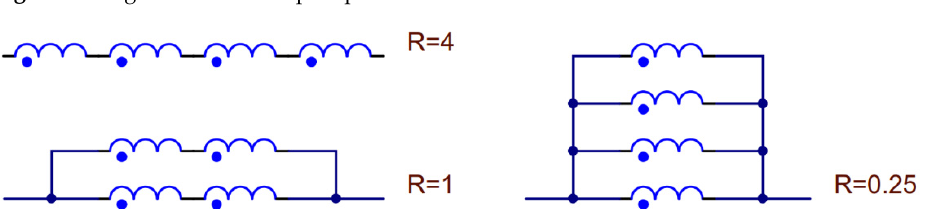
Figure 4. Original and modified motors GBM5208—original (left) and modified (right) .